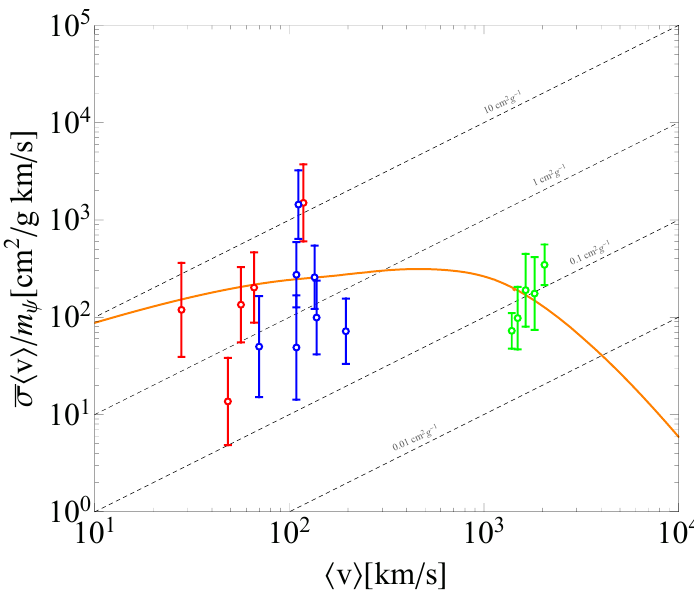
Figure 3 . The averaged cross section of Majorana DM per unit mass ¯ σ h v rel i /m χ as a function of h v rel i for benchmark point m χ = 200 GeV, m φ = 5 MeV, α = 0.3. Data [38] inferred from dwarfs (red), LSB galaxies (blue), groups(left green), and clusters (right green) data.